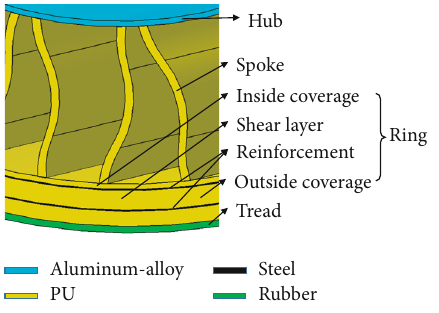
Figure 6: Structural and material compositions of the nonpneumatic tire.